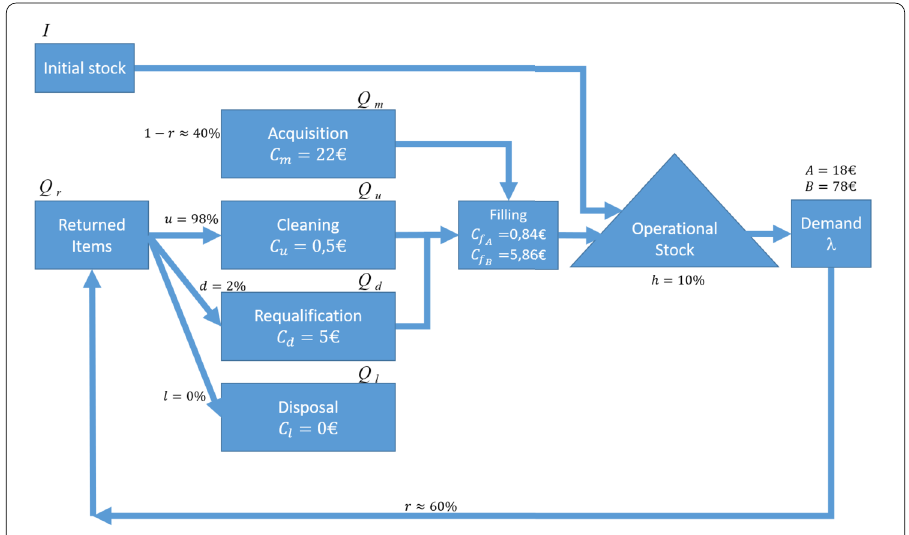
Figure 3 Reverse flows and inventory stock costs in